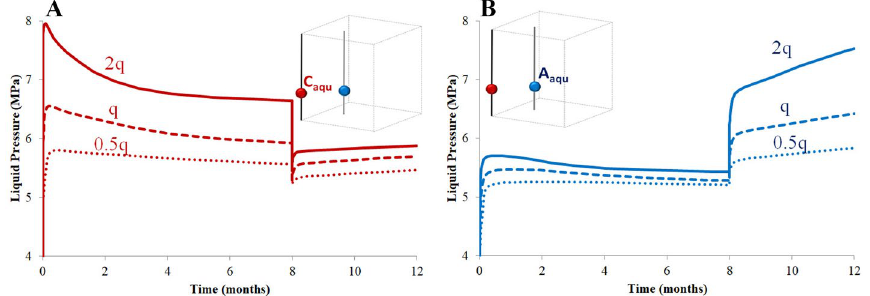
Fig. 19 Liquid pressures on the top of the aquifer for different injection flow rates (0.5q, q and 2q): central well ( A ) and auxiliary well ( B